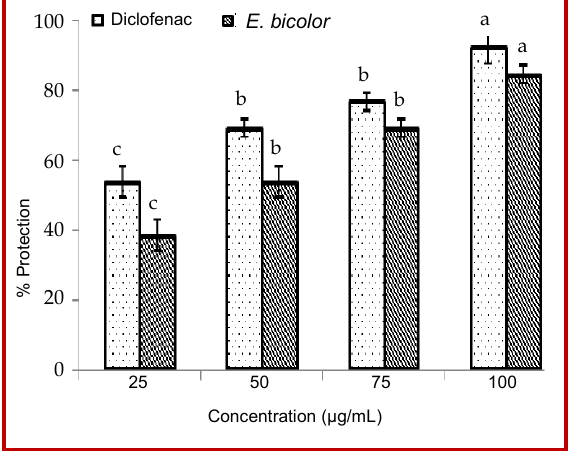
Concentration Figure 3: In vitro anti-inflammatory activity by HRBC mem- brane stabilization method of standard diclofenac and E. bicolor